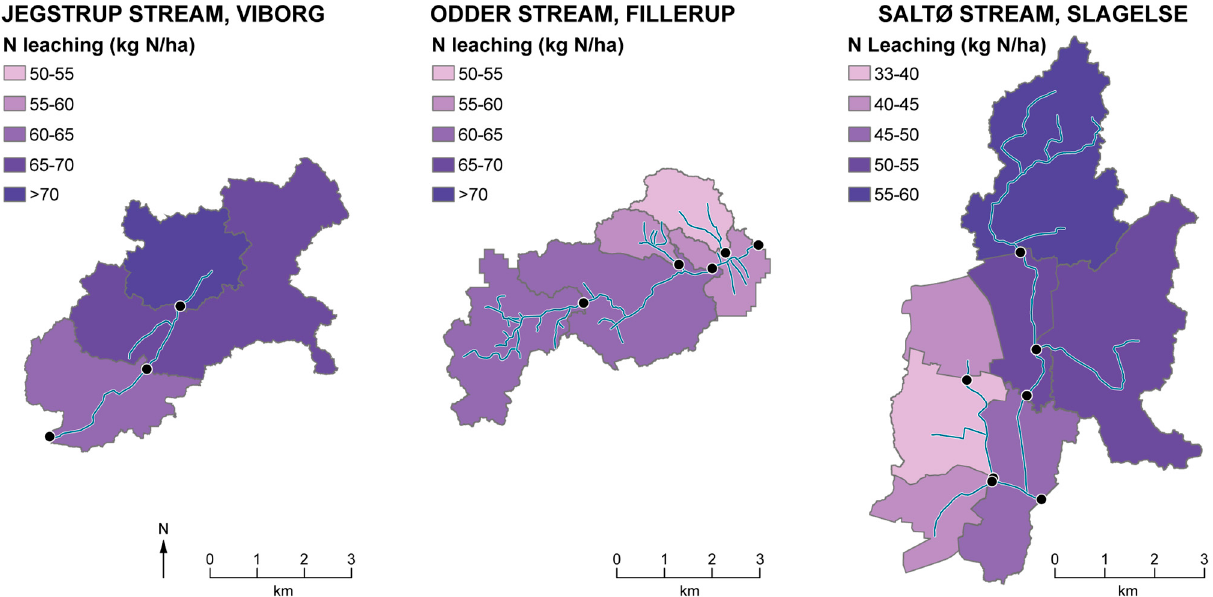
Figure 2. Average nitrate (NO 3 -N) leaching from agricultural areas from 2015 to 2016 in the three catchments Jegstrup, Odder, and Saltø.